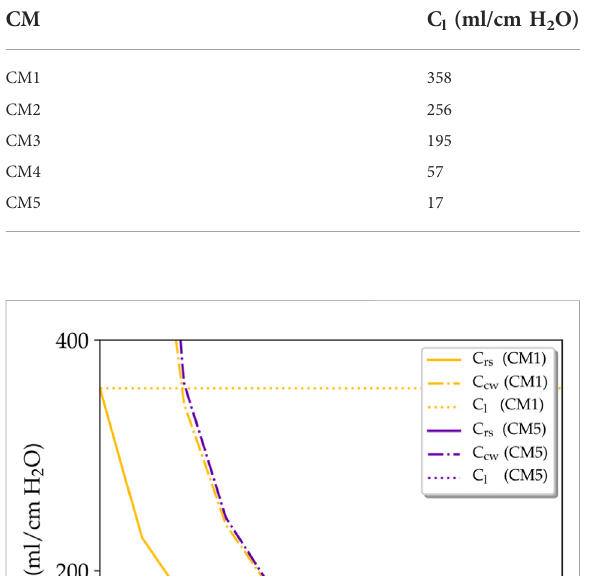
TABLE 3 Lung compliance for each model (unrestrained lung).